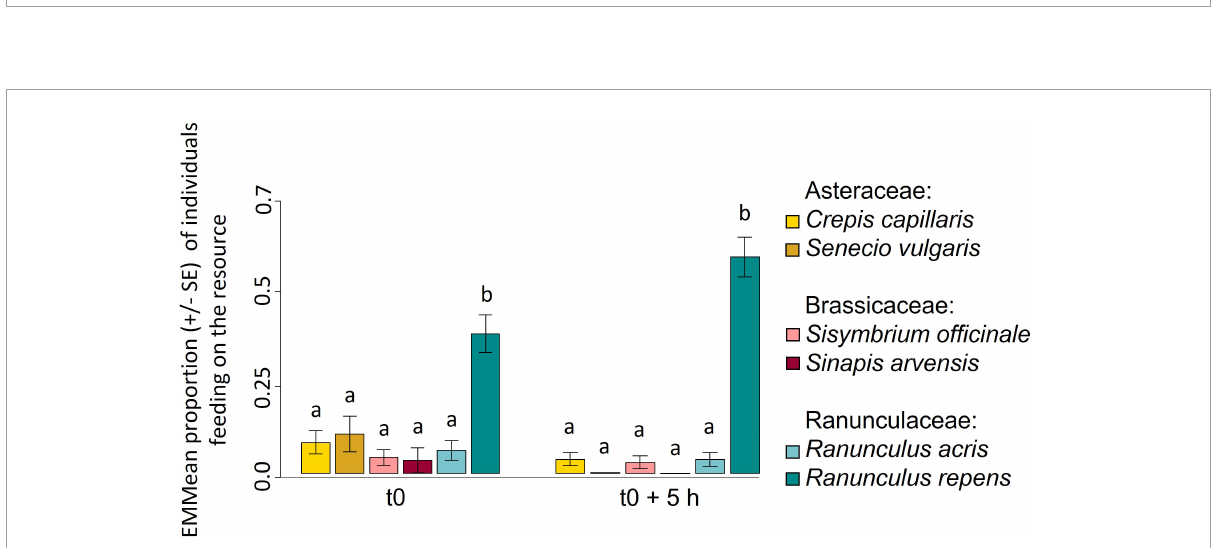
FIGURE4 Relationships between the plant digestible carbohydrate content, the insect preference observed in the multi-choice experiment, and the performance and energetic budget of individuals fed with single species. Pearson’s correlation coefficients ( r ) indicate the strength and direction of the relationship. Axis values are the values of the measured variables. Results of the correlation tests are summarized in the chart at the bottom left, with putative directional relationships.